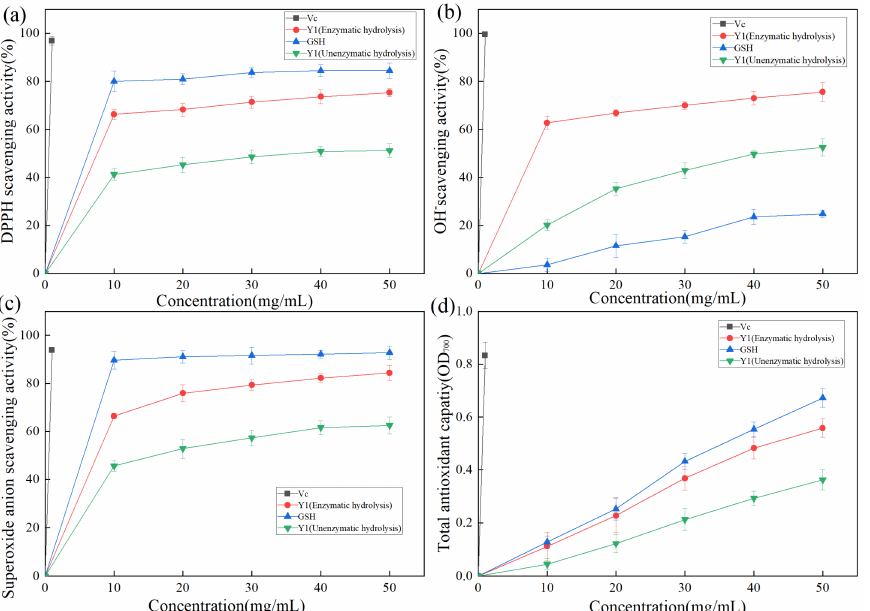
Figure 7. ( a ) Scavenging activity of Y1 DPPH radical of enzymolysis product; ( b ) Scavenging activity of Y1 hydroxyl radical of enzymolysis product; ( c ) Superoxide anion radical scavenging activity of enzymolysis product; ( d ) Determination of the reducing force of enzymolysis product